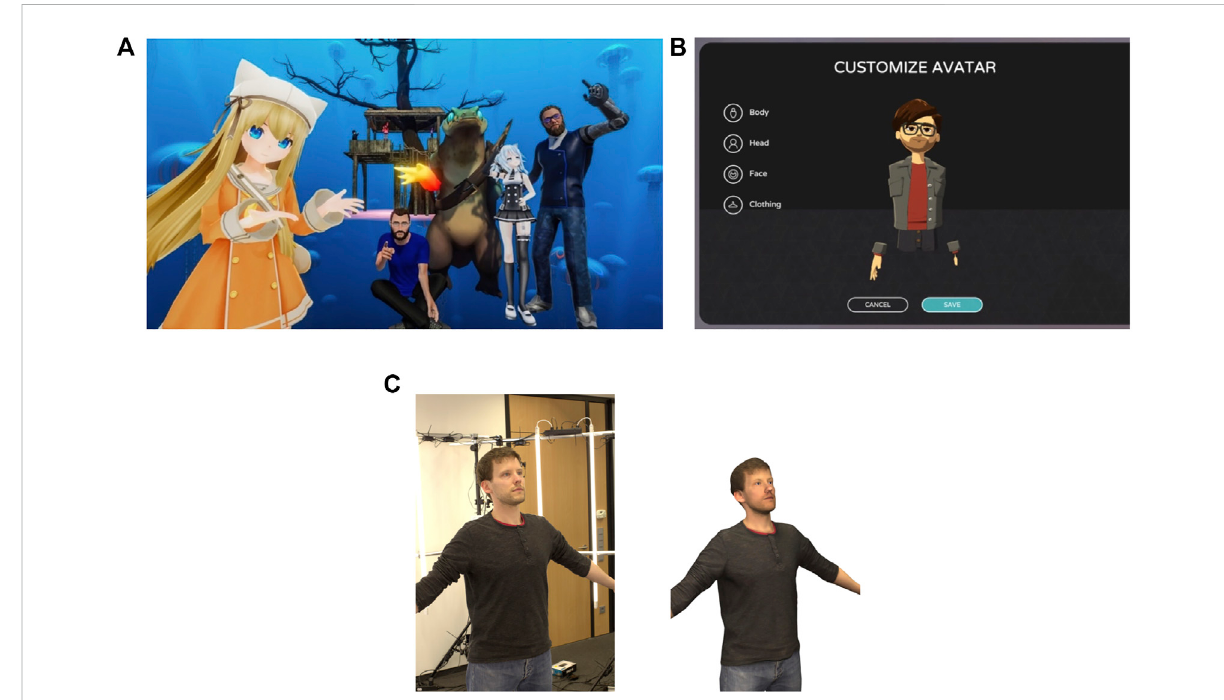
FIGURE 1 Examples ofthree types of self-representations insocial VR. (A) Self-uploaded avatar.Example:various ofself-presentations uploaded by users in VRChat 5 . (B) Customizable avatar. Example: the avatar customization interface in AltSpaceVR 6 . (C) Personalized (photo)realistic avatar. Example: generating a photorealistic avatar from a body-scanner. Panel reproduced from (Achenbach et al.,